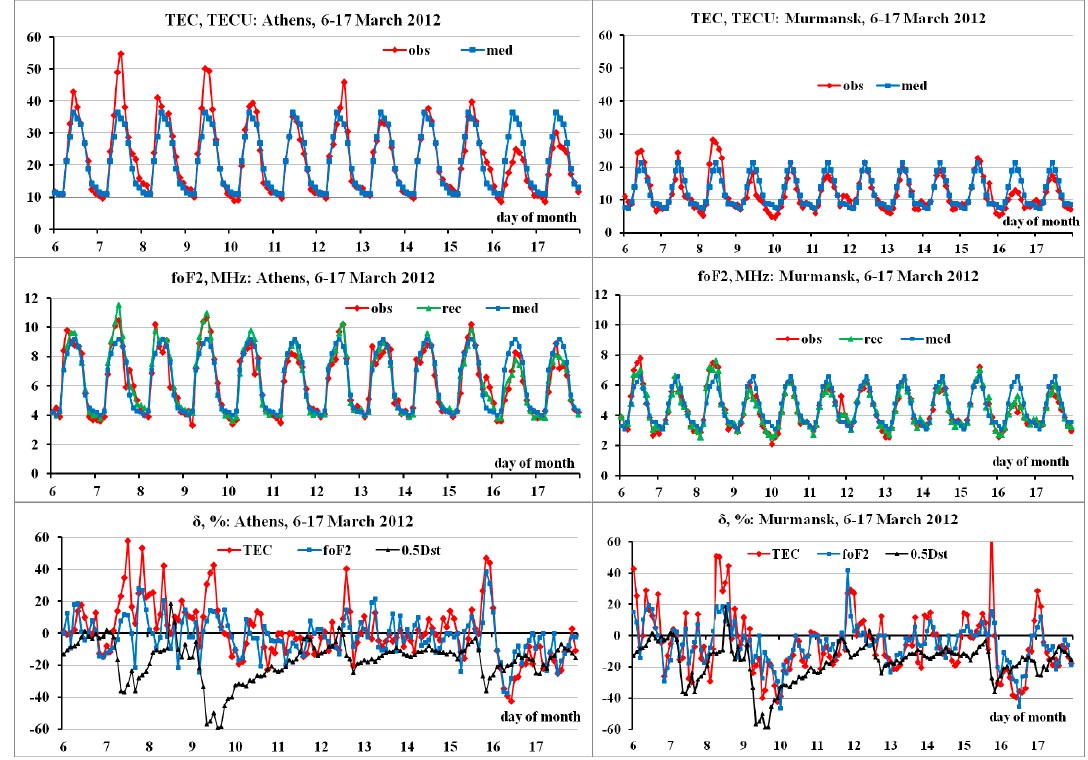
Figure 5. Statistics of the disturbed state according to the data of two stations, including changes in the parameters TEC and fo F2 and their relative deviations, δТЕС and δ fo F2.